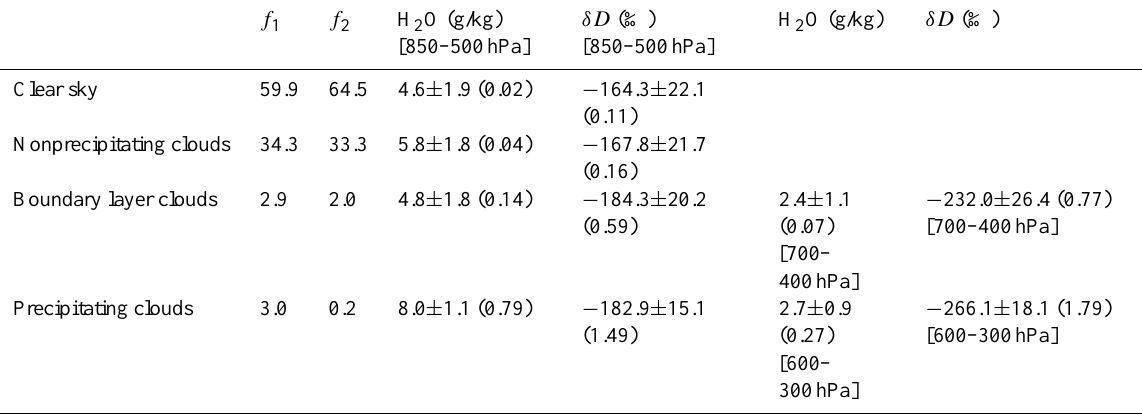
Table 1. The mean, standard deviation and standard error of the mean for TES water vapor measurements and HDO/H 2 O ratio (in parts per mil relative to SMOW) for the June, July and August months between 2005 and 2008 over the tropical ocean. All mean δD values are mass-weighted. Standard error of the mean is presented in parenthesis next to standard deviation. The frequency of observations from the ozone profile step, which is the TES retrieval that is most sensitive to all cloud types, is denoted as f 1 . The distributions of cloud optical properties from the water vapor retrieval step are shown in the second column (denoted as f 2